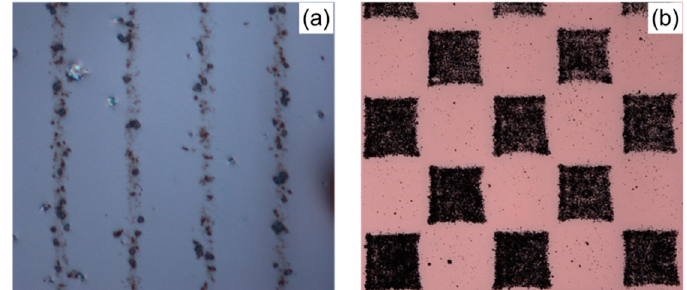
Figure 8. Optical microscope images of 1D fringes ( Λ = 14 µm) ( a ) and 2D square (side 200 µm) ( b ) patterns of nanometric spore and pollen fragments on x ‑ cut and z ‑ cut LiNbO 3 :Fe crystals, respectively. Taken from Martínez ‑ Muñoz et al. J. Phys. Conf. Ser. 2017 , 867 , 012030 (reference [37]).